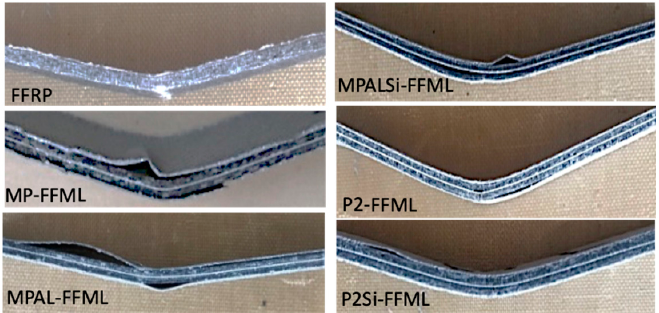
Figure 13. The side view of FFRP and five types of surface-treated FFMLs following three-point bending tests.